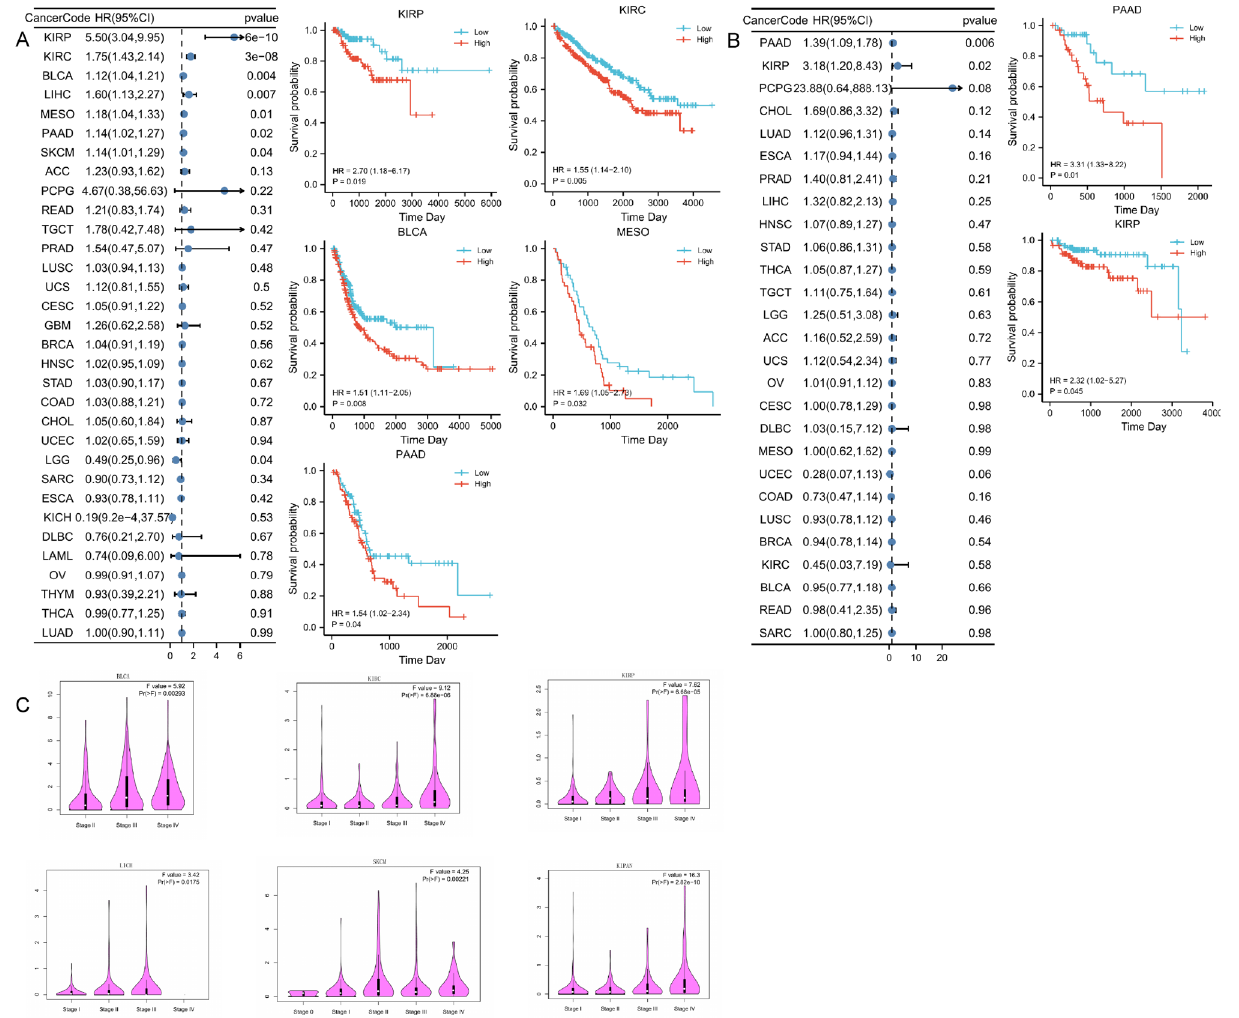
Figure 2. The relationship between IGFL2 and clinical prognosis. ( A ) Prognosis of IGFL2 in overall survival. ( B ) Prognosis of IGFL2 in disease-free survival. ( C ) Positive correlation between IGFL2 and cancer staging in the GEPIA